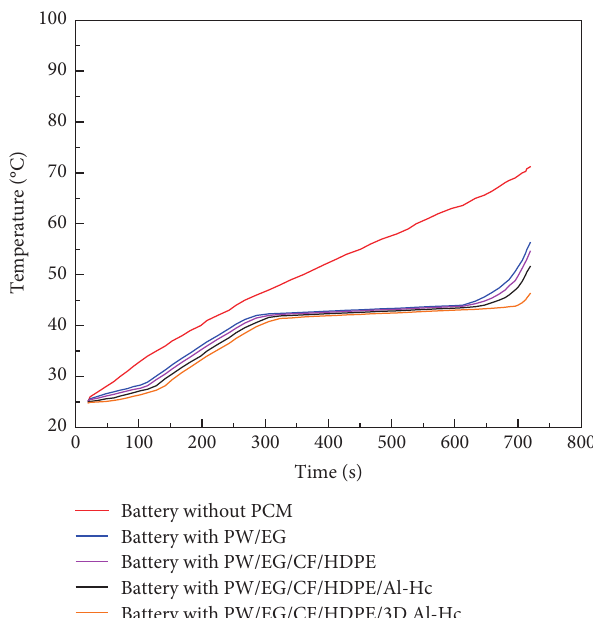
Figure 12: Temperature variations with time for the battery surface at a 2.5 ° C discharge